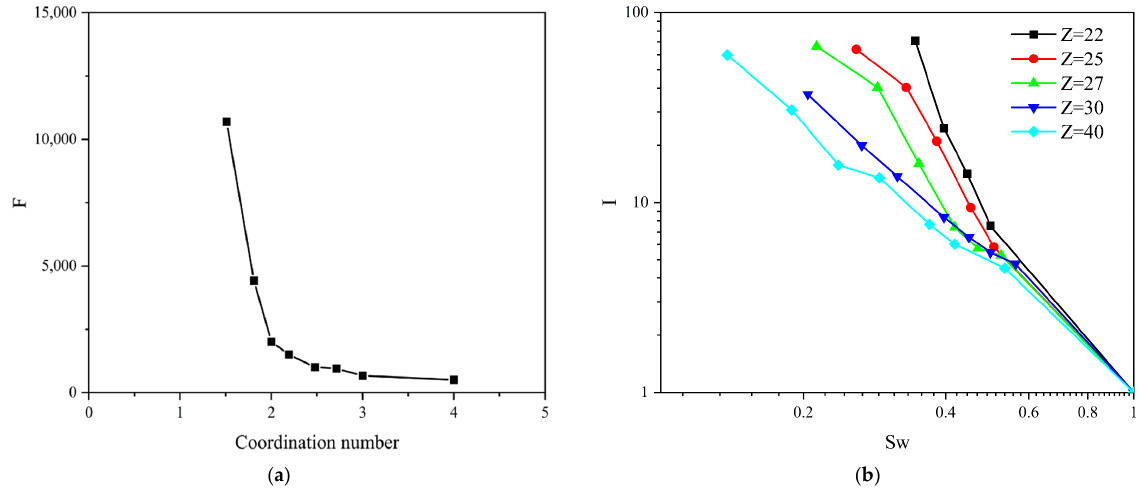
Figure 19. The influence of the average coordination number on the electrical properties of rocks: ( a ) relationship curves between different average coordination numbers and formation factors; ( b ) I-Sw curves under different average coordination numbers.